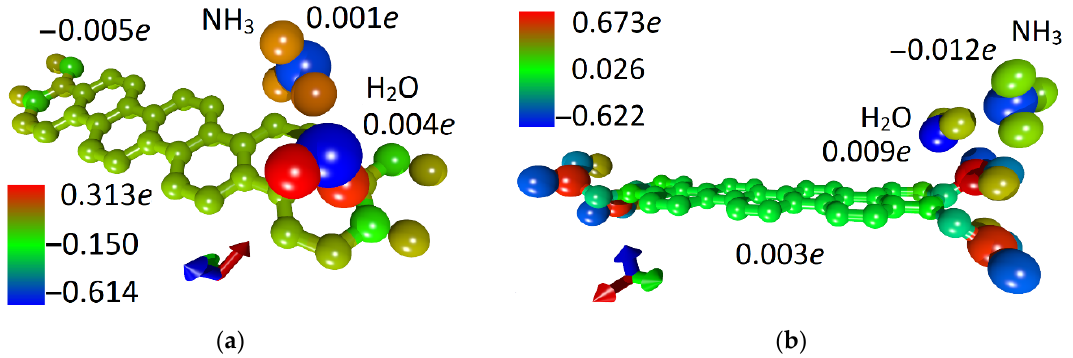
Figure 5. 4D patterns of the distribution of the electron charge density over the atoms of the supercell with adsorbed ammonia molecules on a wet surface: ( a ) 32ZGRNR–4H nanoribbon; ( b ) 32ZGRNR–4COOH nanoribbon.